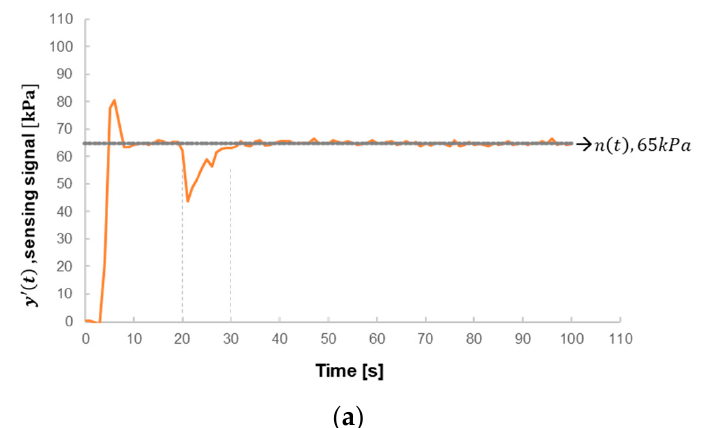
( b ) Figure 10. When the PID parameter is set K p = 0.05, K i = 0.1, K d = 0, ( a ) The sensed pressure change, and ( b ) The change in PID modulating PWM output, before and after pressing down the micro spray gun. 4. Discussions Aiming at the experiment results, three points are discussed.